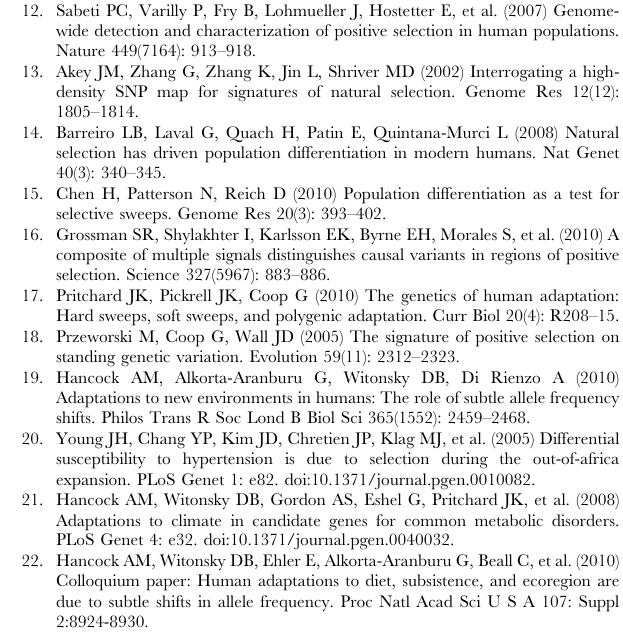
Table S3 Environmental variables for each population. Values were averaged for each country. Table S4 Enrichment of genic SNPs for different classes of similar Minor Allele Frequencies (MAF), F ST or recombination rate. Table S5 Improvement of explained variance (termed I(R 2 ) ) values and their p- values for the whole set of genes. Table S6 Genes having at least one significantly associated SNP with Bayenv software (ranked Bayes factor . 0.995) for one variable for each environmental class. Table S7 Gene ontology analysis results (Function and Compo- nent domains) for SNPs mapping on genes which correlate with pathogen diversity. Table S8 Annotation of genes correlated with pathogen